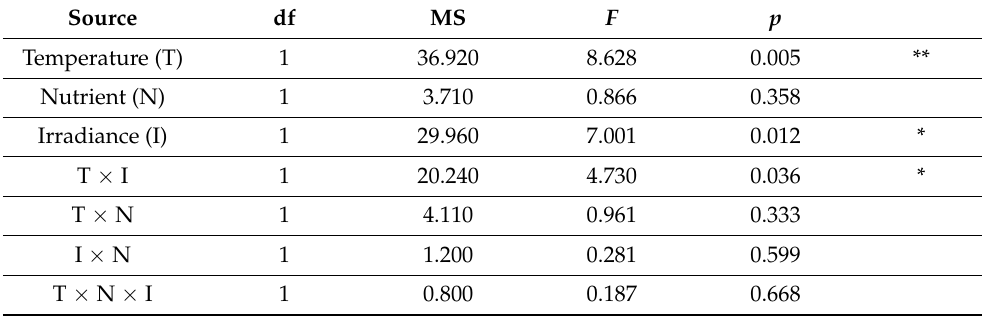
Table 1. Results of three-way ANOVA on the effects of temperature, nutrient availability, and irradiance on the specific growth rate of Sargassum fusiforme . Sources that are significant at p < 0.05 and p < 0.01 are denoted as ‘*’ and ‘**’